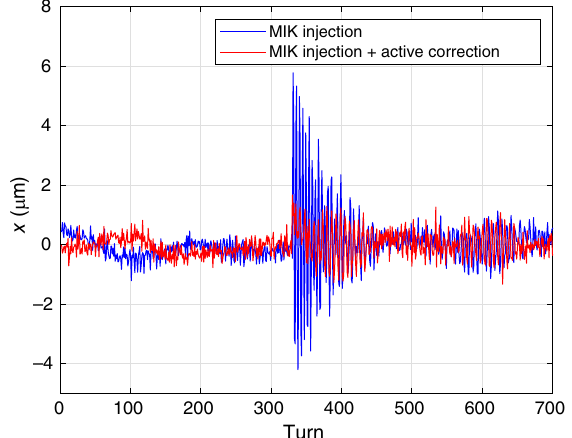
FIG. 17. Variations of the rms horizontal stored beam size due to the MIK. The peak variation is 3.5% of the rms horizontal stored beam